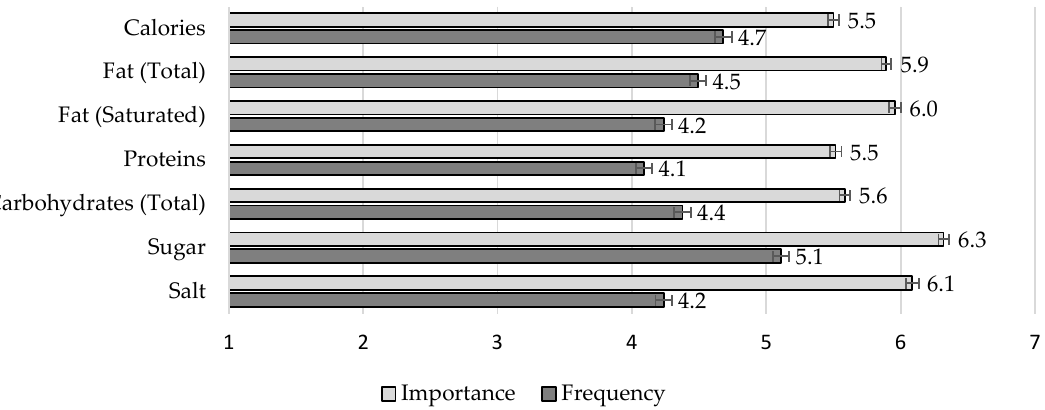
Figure 2. Frequency of use and perceived importance according to the type of nutritional information.